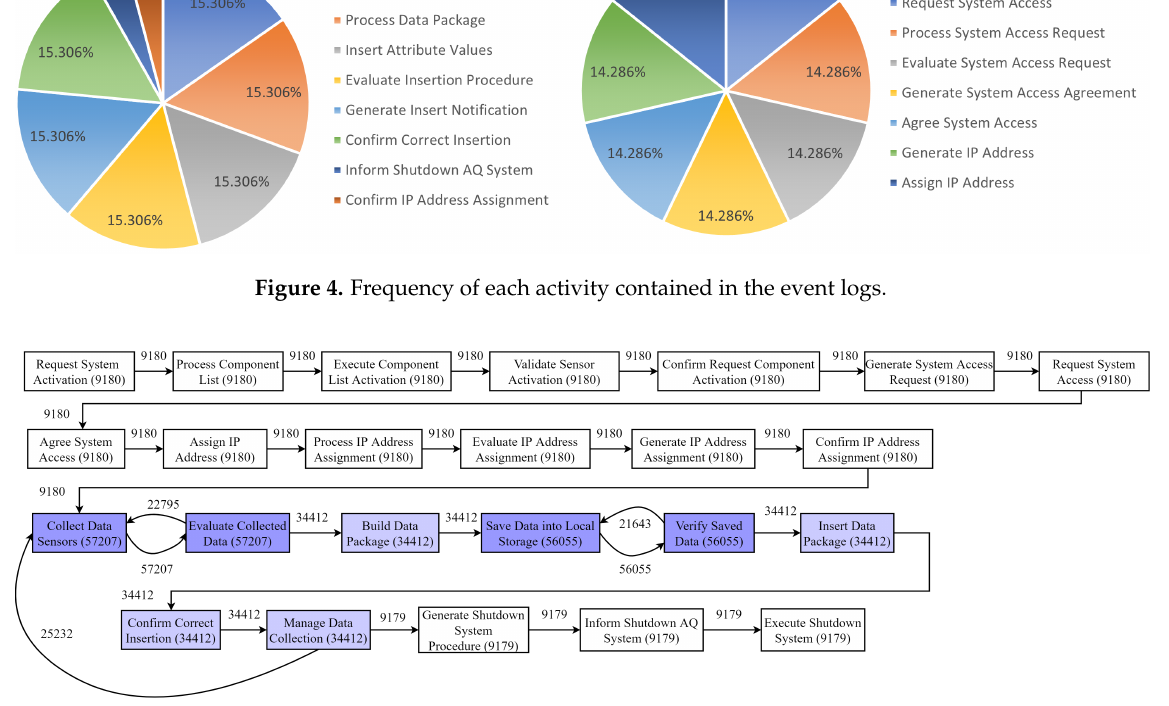
Figure 5. Process model discovered using DFG algorithm for IoT Air Quality Monitor participant event